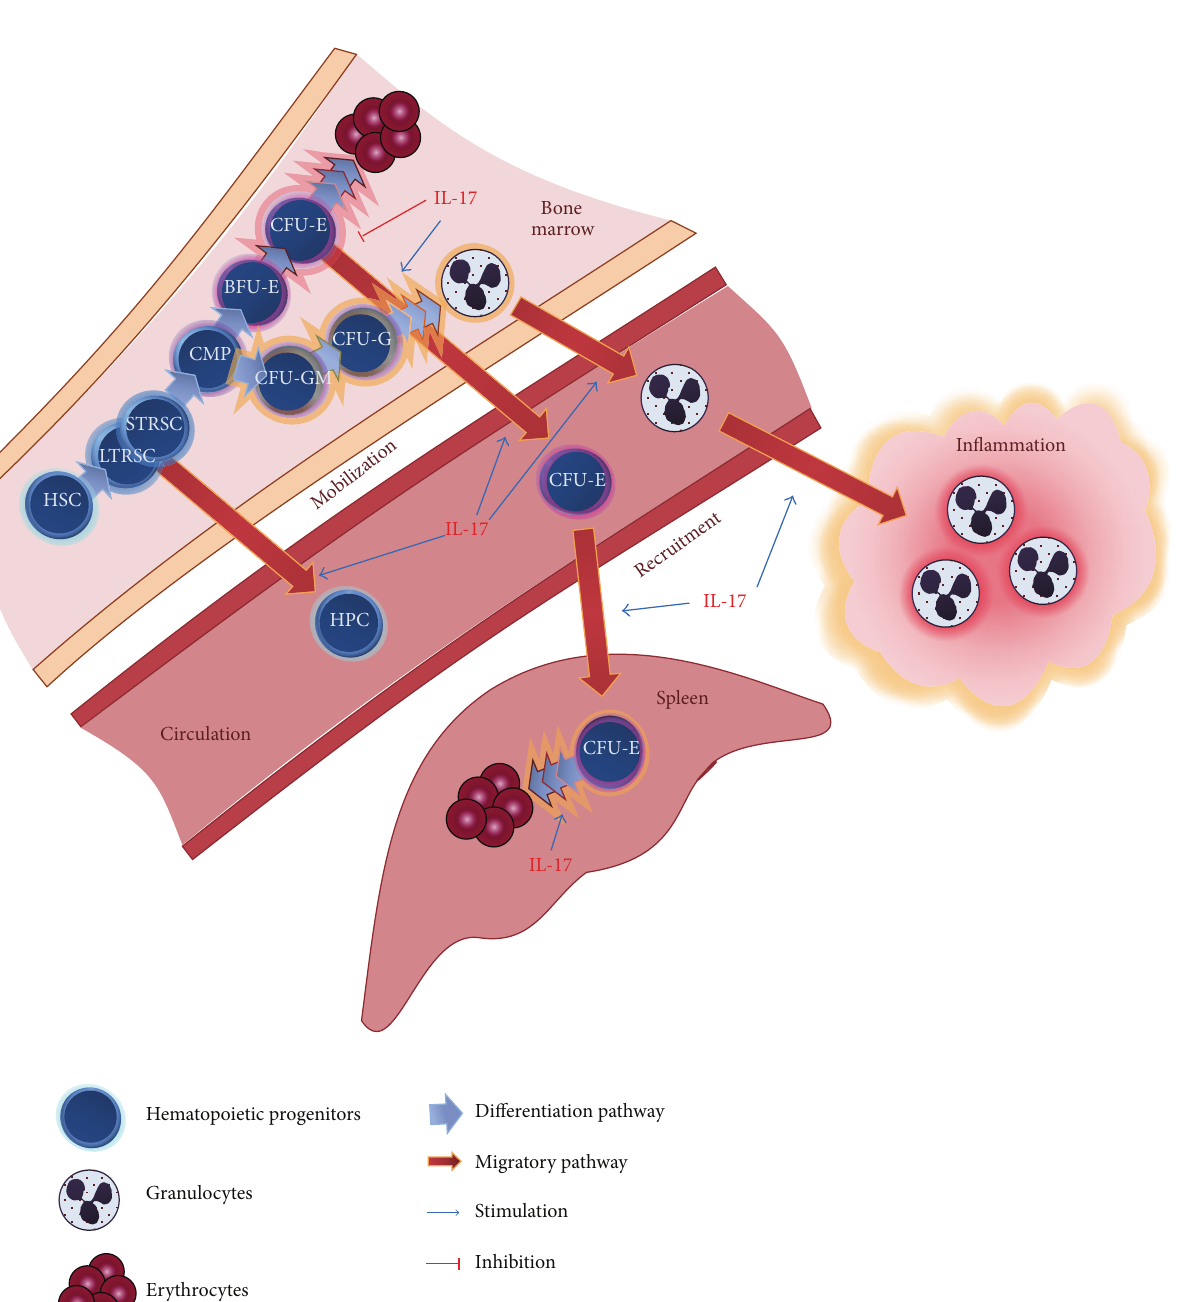
differentiation [92]. The latter was, at least partially, mediated through induction of cyclooxygenase-2 expression and